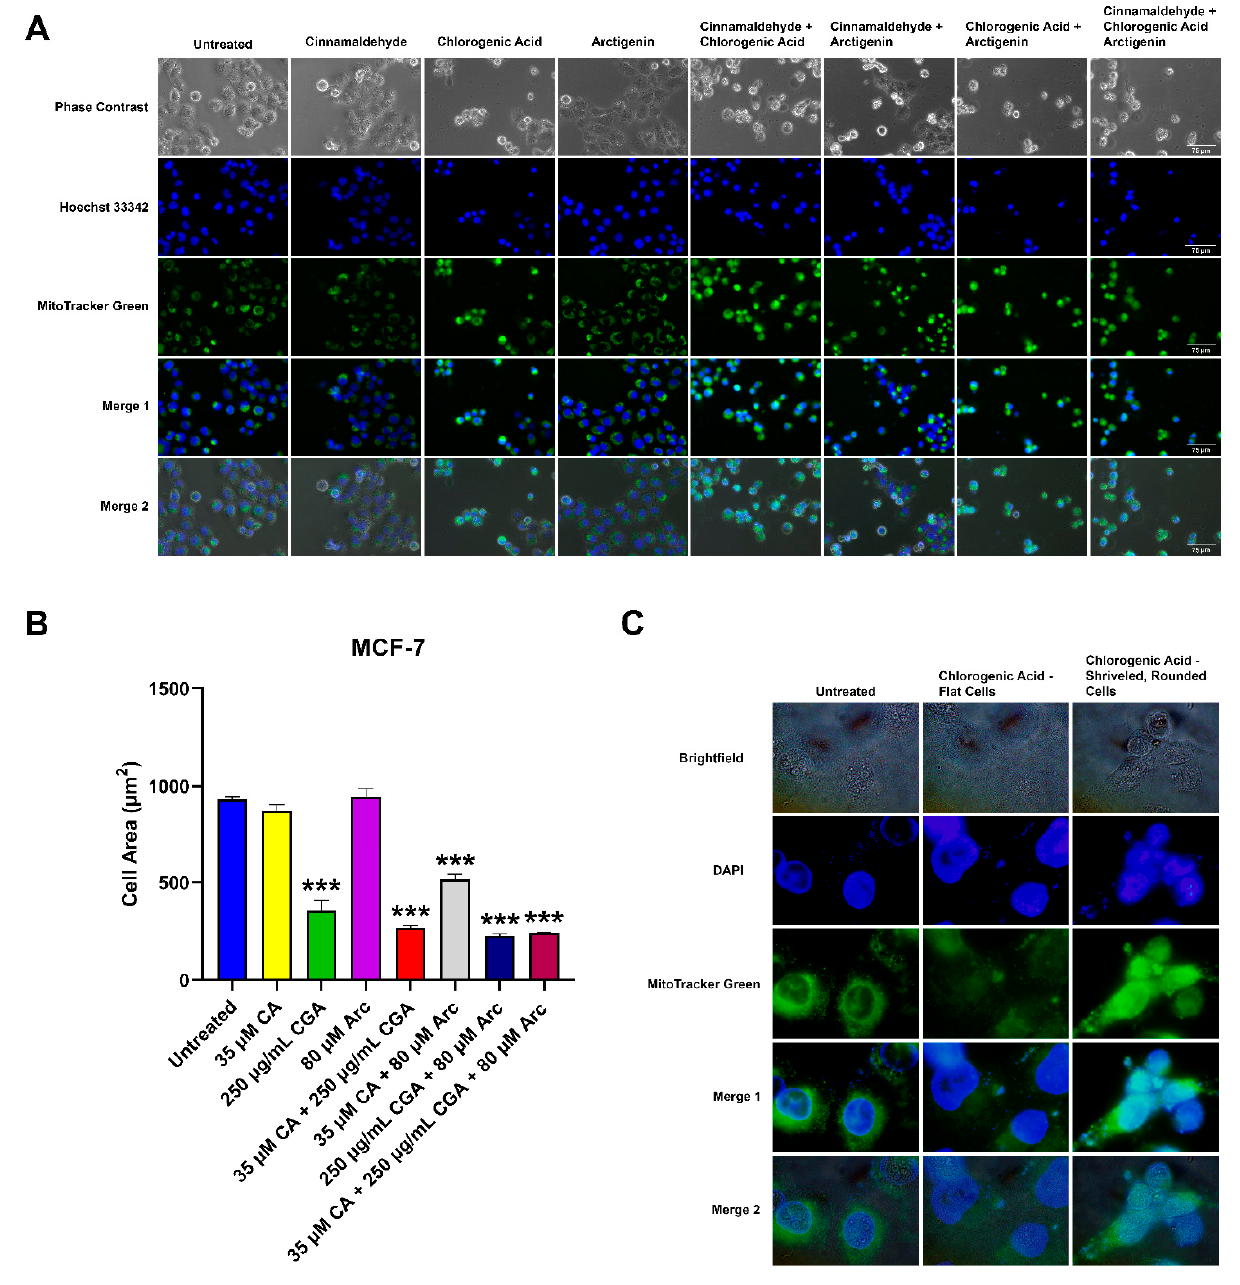
Figure 8. Cellular, mitochondria, and nuclear morphologies of MCF-7 breast cancer cells treated with 35 μ M CA, 250 μ g/mL CGA, and 80 μ M Arc, alone and in combination, for 24 h. ( A ) Representative fluorescence microscopy images of MCF-7 breast cancer cells treated with CA, CGA, and Arc, alone and in combination, for 24 h. MCF-7 cells were stained with final concentrations of 150 μ M MitoTracker ® Green FM and 1 μ g/mL of Hoechst 33342 before visualization at 40× magnification (scale bar = 75 μ m). ( B ) Cell area measured from 40× phase–contrast images of MCF-7 cells treated with CA, CGA, and Arc, alone and in combination, for 24 h. Bars represent the cell area mean values ± SEM of three experimental replicates ( n = 3). Statistical significance compared to untreated: *** = p < 0.001. ( C ) Representative fluorescence microscopy images of MCF-7 cells treated with 250 μ g/mL CGA for 24 h at 100× magnification. MCF-7 cells were stained with a final concentration of 150 μ M MitoTracker ® Green FM and were mounted with DAPI/Antifade (0.4 μ g/mL of DAPI) before visualization at 100× magnification.